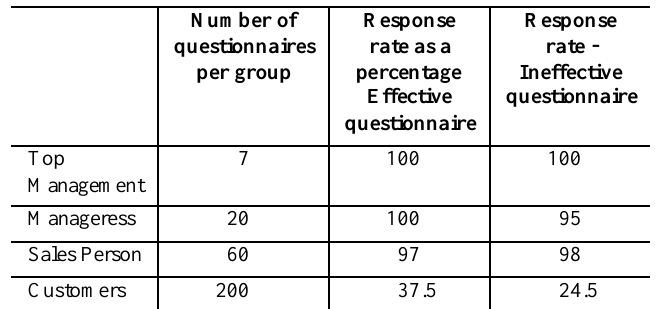
Table 1: Questionnaire response